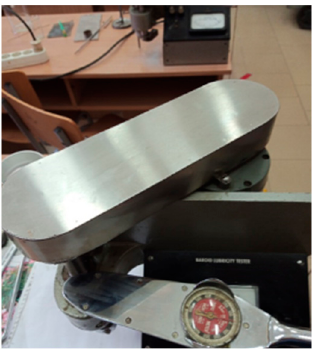
Figure 3. The Baroid tribometer lubricity tester.